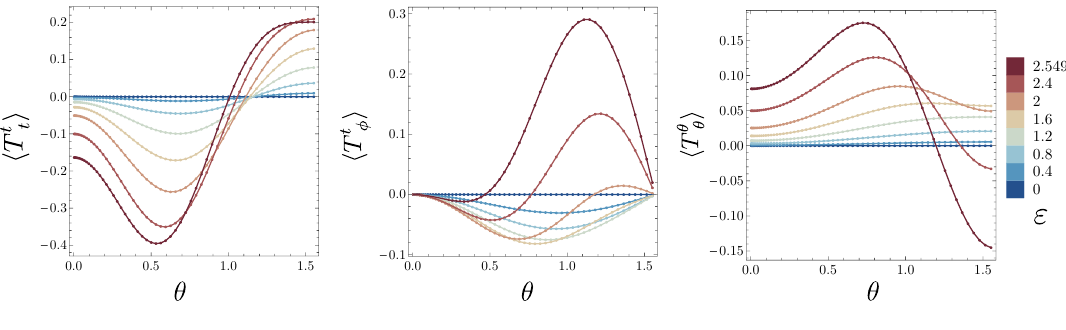
Figure 8 . The stress-energy tensor component h T t nent h T (cid:18) i ( right ) for solitonic solutions as a function of (cid:18) , the angle on the S 2 . Colours represent (cid:18) di(cid:11)erent values of the parameter " , with larger values corresponding to larger